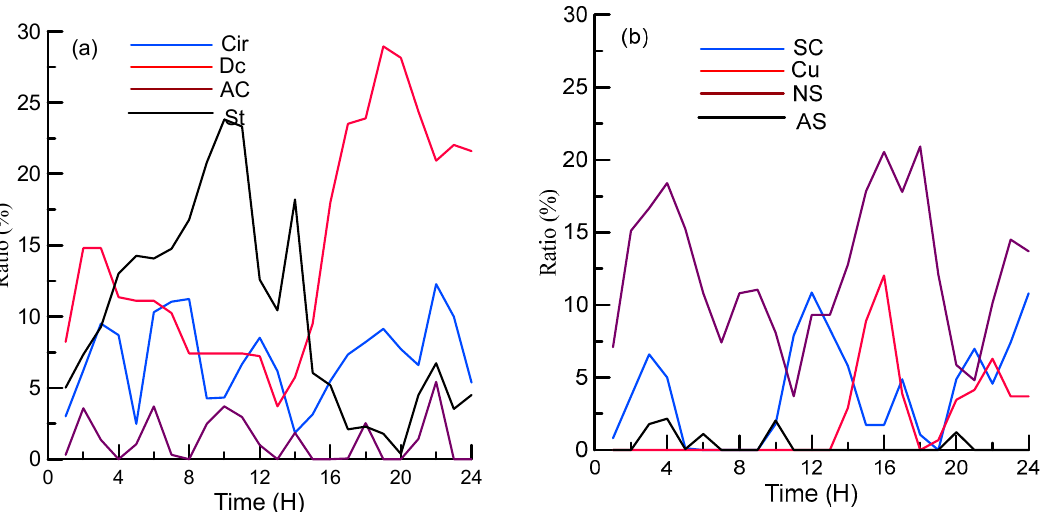
Figure 12. Diurnal variations of the cloud occurrence frequencies corresponding to eight cloud types: ( a ) Cir, Dc, Ac, and St, ( b ) Sc, Cu, Ns, and